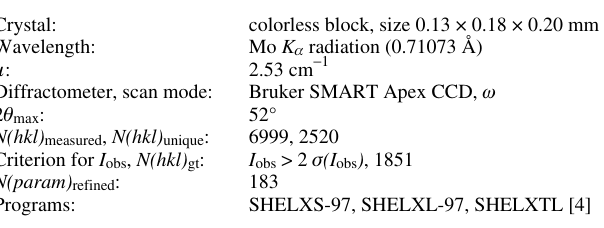
Table 1. Data collection and